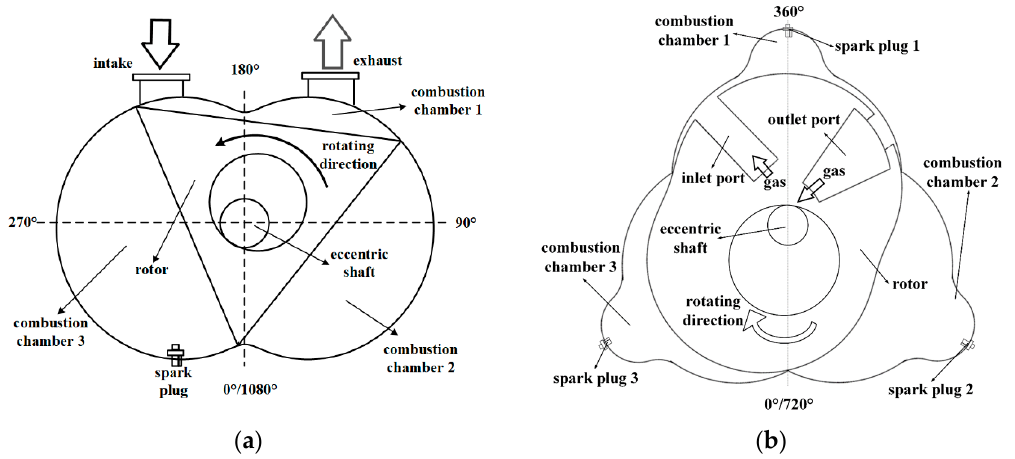
Figure 1. Schematic comparison of XRE: ( a ) WRE, ( b ) XRE.